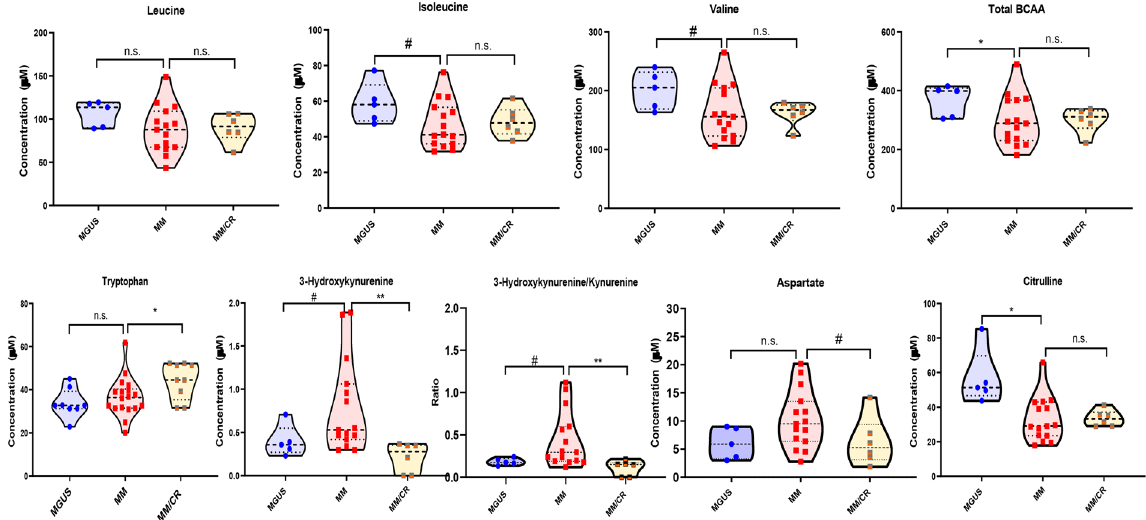
Figure 6. Violin plots comparing the median concentrations of various amino acids and metabolites in the bone marrow plasma between MGUS (N = 5), MM (N = 15) and MM in CR (N = 6) groups. Data was analyzed by Mann-Whitney U test where *** p < 0.001, ** p < 0.01, * p < 0.05, # p < 0.1 but > 0.05, n.s. non-significant.